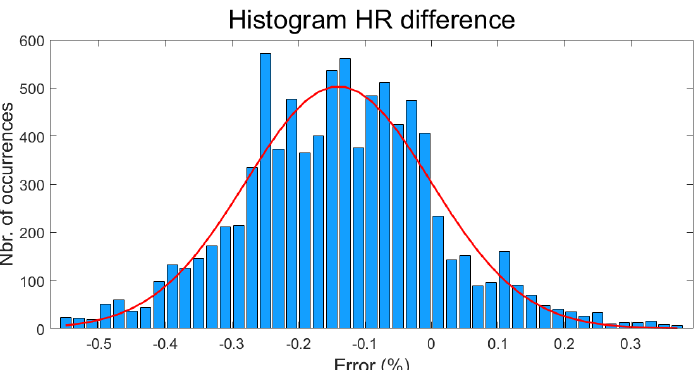
Figure 17. Difference between MsWH and Empatica E4 HR signals. Histogram. Horizontal axis: error (%). Vertical axis: Number of occurrences. Red line: Gaussian fit. The maximum is located at − 0.14%.